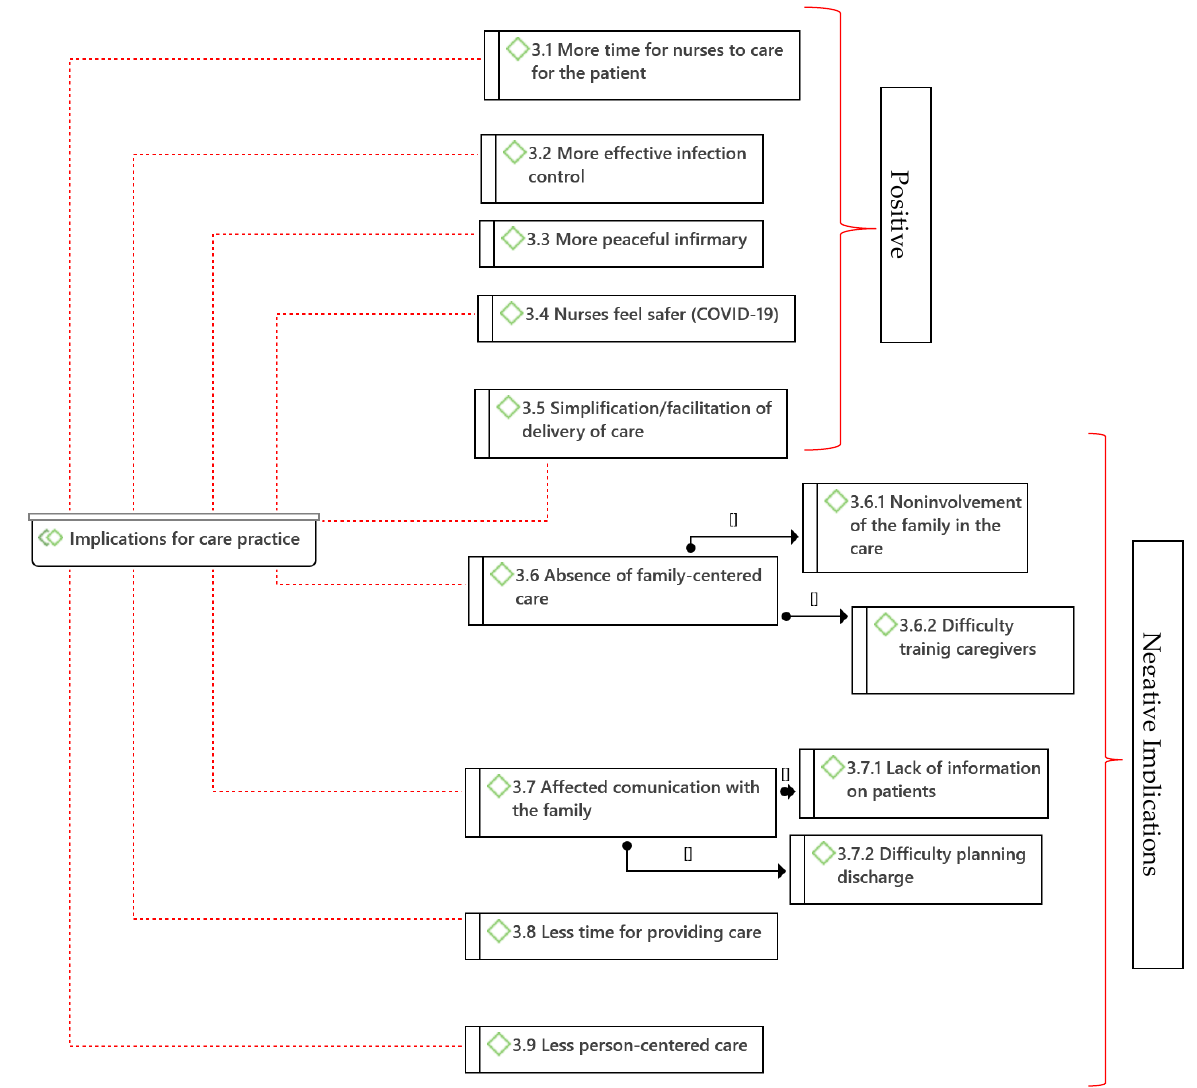
Figure 4. Categories of implications for care practice caused by hospital visit restriction measures (Atlas.ti ®®® ).